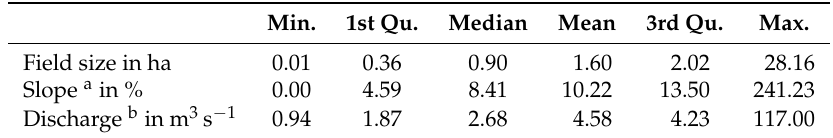
Table 1. Additional properties of the case study catchment. Min. 1st Qu. 3rd